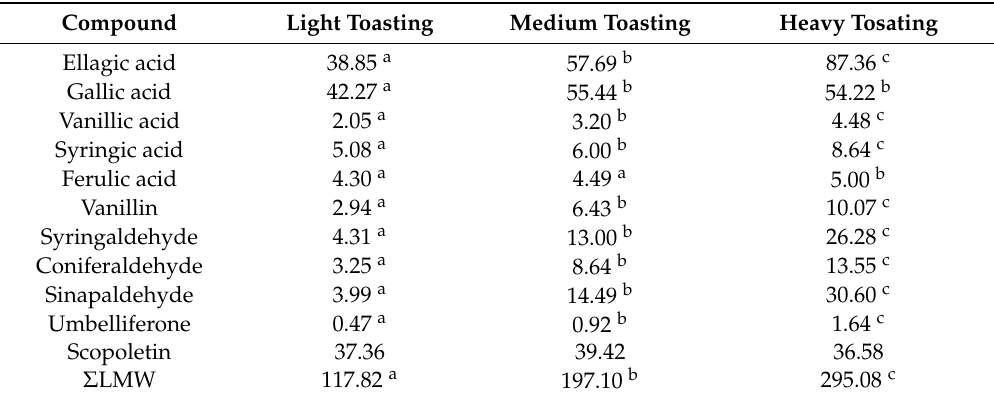
Table 5. Mean concentrations of low molecular weight compounds in wine spirits aged four years in barrels with different toasting